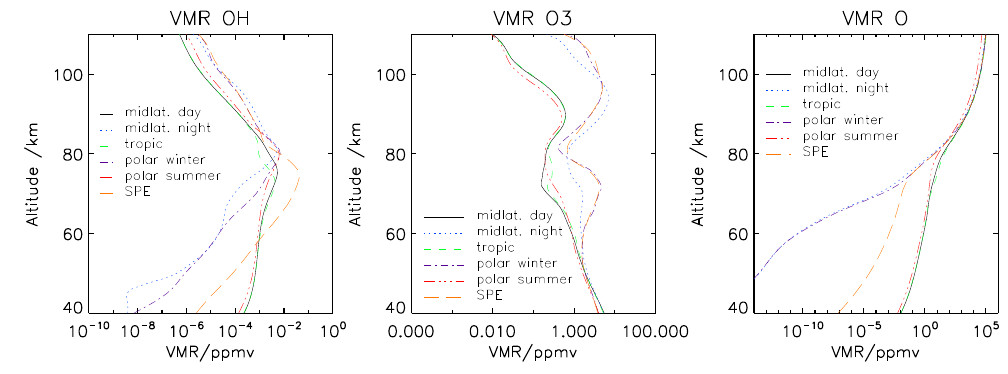
Fig. 2. Assumed mixing ratio profiles of OH, O 3 and O (top to bottom or left to right, according to final formatting ) for various atmospheric conditions.